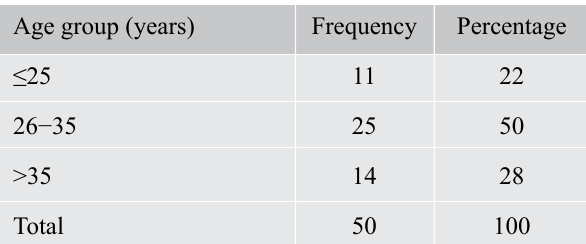
Table I: Age distribution of the patients (N=50)